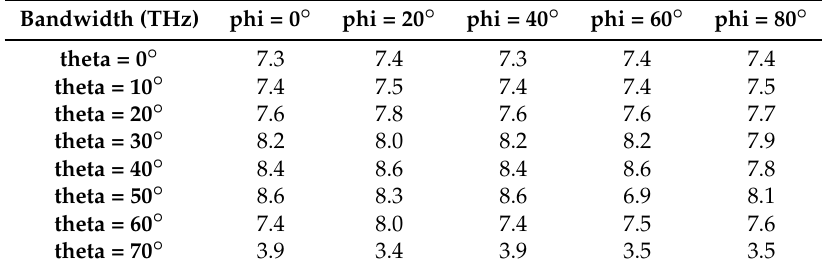
Table 2. Absorption bandwidth under the changes of the incident angle theta for TM incident